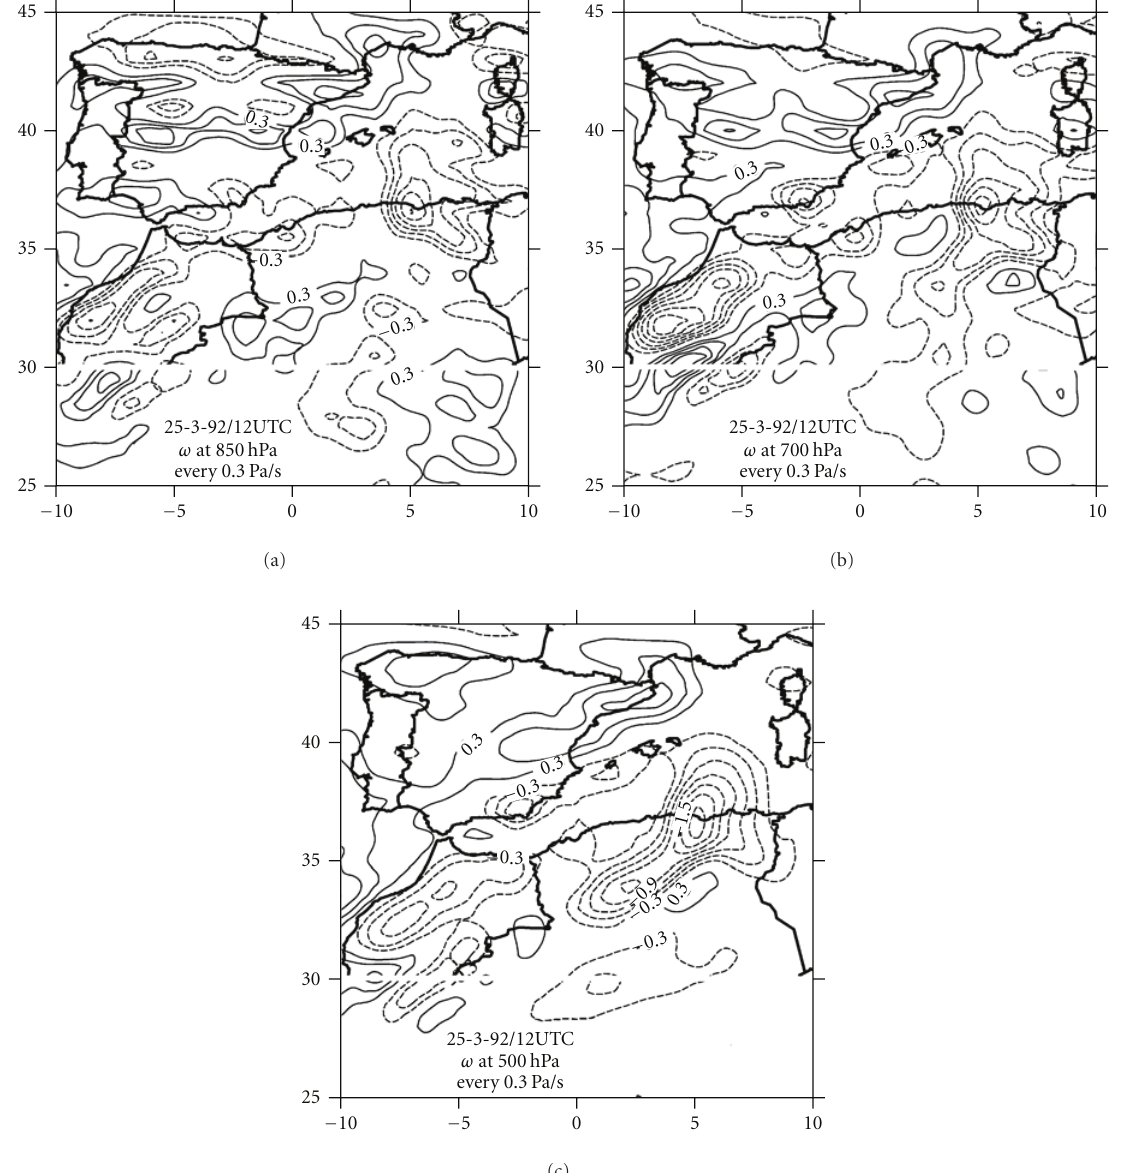
Figure 2: Vertical velocity fields at 12:00 UTC on 25 March 1992 at, (a) 850 hpa, (b) 700 hpa, and (c) 500 hpa. Isopleths of vertical velocity: every 0.3Pas − 1 (dash: upward; continuous: